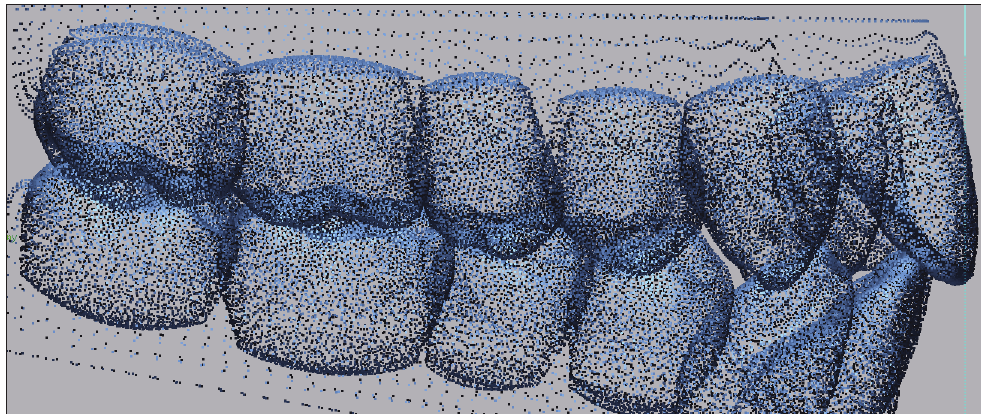
Figure 1. Point cloud model derived from a 3D scan showing the multiple points identified by the software on each